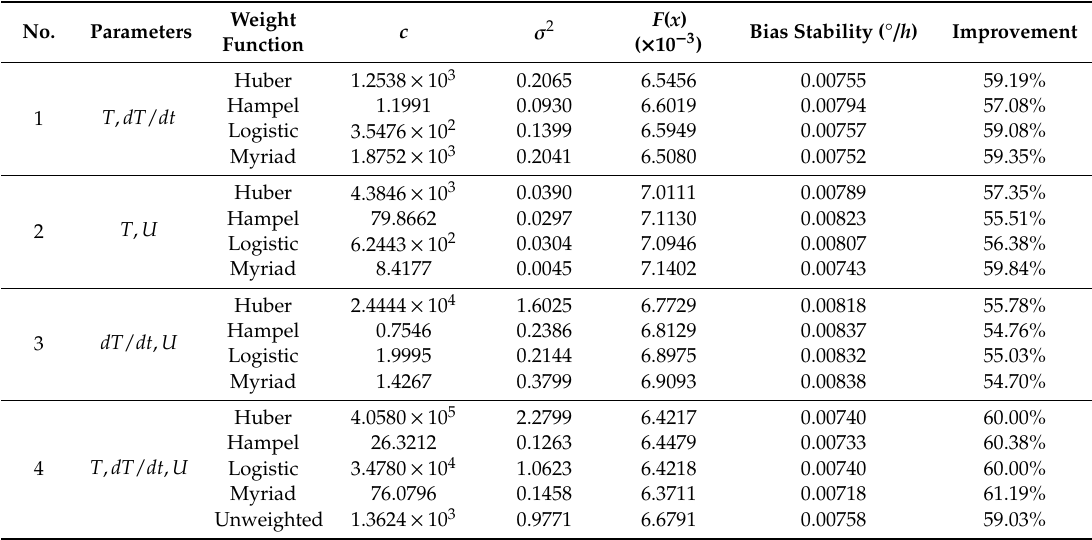
Table 5. TRPLG bias stability for compensated data based on IR-LSSVM model using di ff erent composite